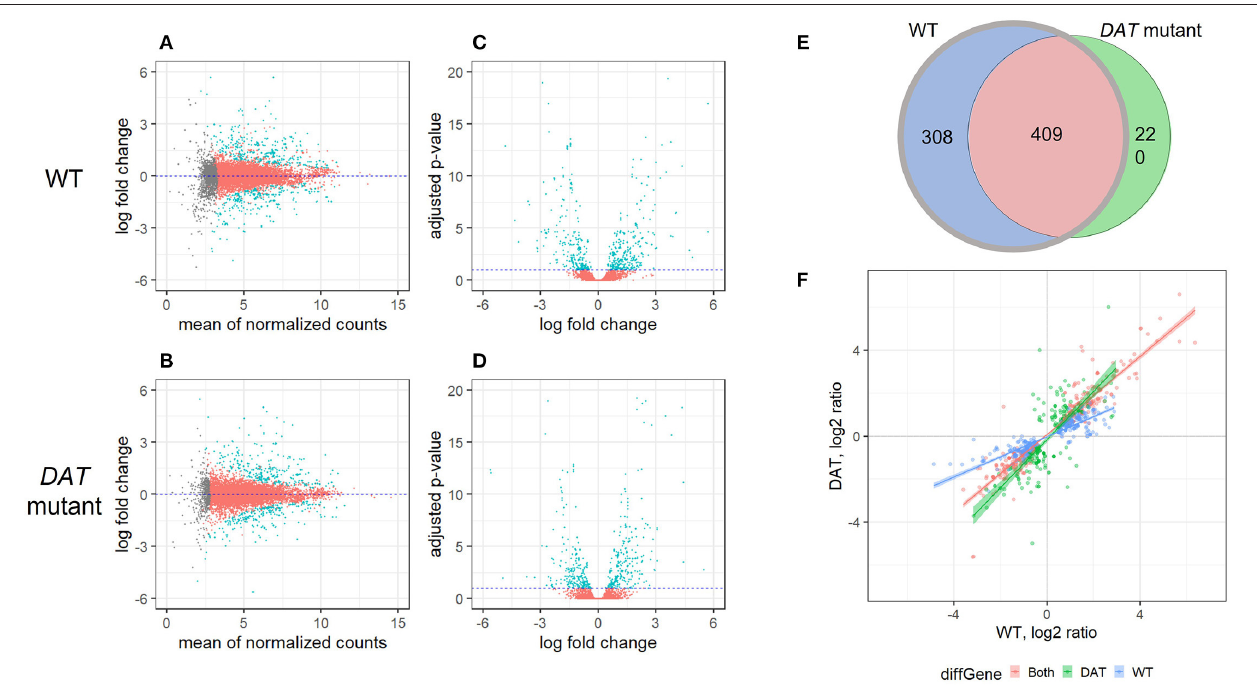
FIGURE 1 | Differential gene expression in response to AMPH in DAT mutant and isogenic control. (A–D) are gene expression scatterplots for the two strains of flies: WT ( w 1118 isogenic strain) and DAT mutant. (A,B) are MA plots and (C,D) are volcano plots. In (A–C) , differentially expressed transcripts (DE transcripts, those that change their expression in treatment vs. vehicle) are shown in teal; transcripts with changes below the statistical cut-off are in red, while transcripts for which the differential expression status could not be resolved are shown in gray. (E) Overlap between the DE transcript sets between WT (gray circle) and DAT mutant (black circle). At FDR < 0.1, there were 717 DE transcripts in the WT strain and 629 DE transcripts in the DAT mutant flies. The two lists of DE transcripts had 308 genes that were DE only in WT (blue), 220 transcripts that were DE only in DAT (green) and 409 transcripts in common (red). (F) Comparison of the expression level changes between the WT and DAT mutant strains. The 409 DE transcripts shared between the two strains are shown in red; the 220 DAT mutant-specific DE transcripts are shown in green, and the 308 WT-specific DE transcripts are shown in